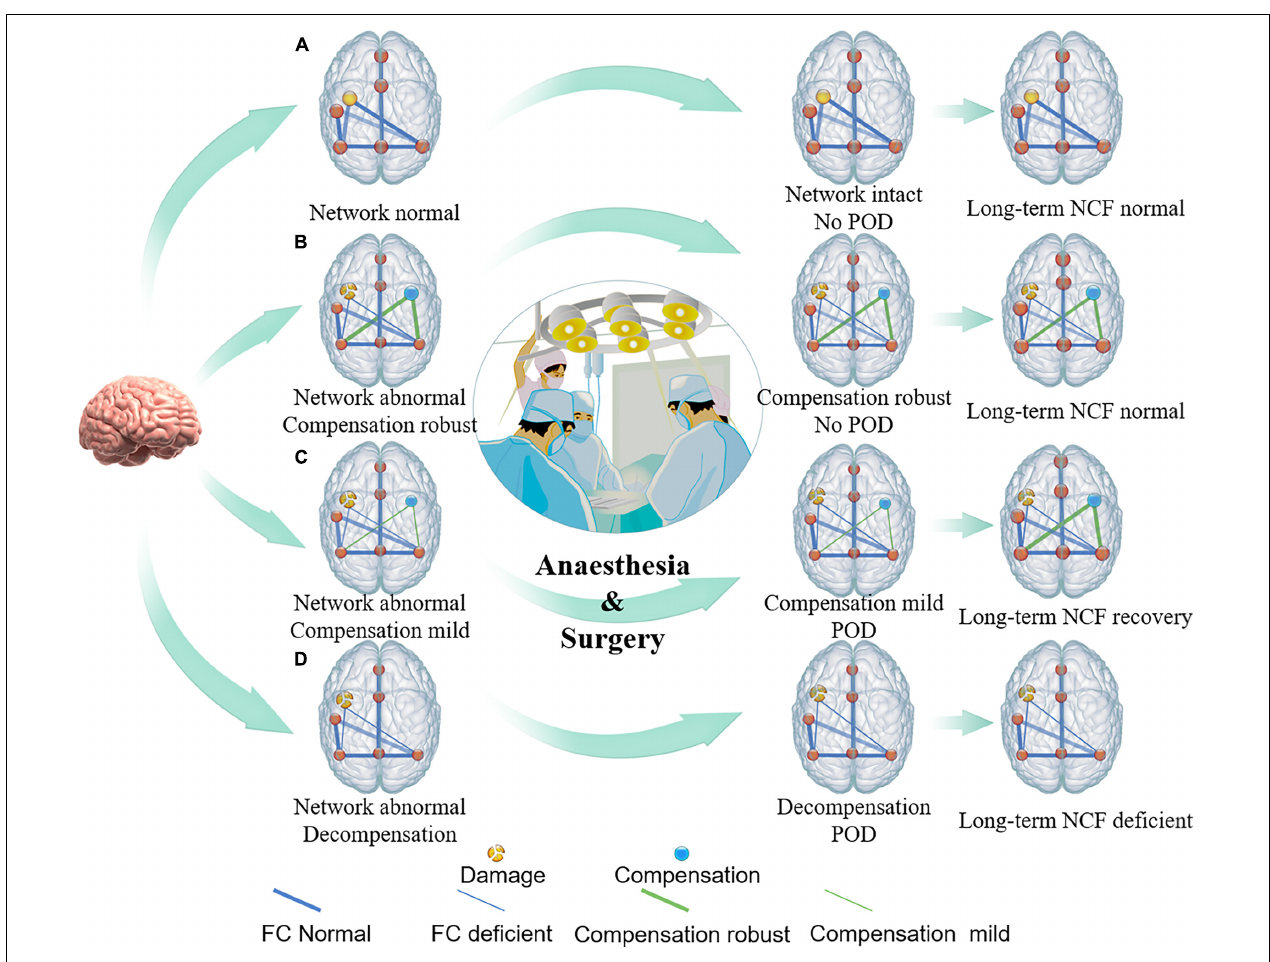
FIGURE 4 | Conceptual model of relationship between brain damage, brain compensation, and POD. The conceptual model illustrates that premorbid integrity of individual brain regions (yellow intact or broken dots on the left side of brain) and/or brain connectivity (thick or thin blue line), as well as robustness of brain compensation (yellow dots and green line on the right side of brain), may relate to the POD incidence under conditions of heightened stress from surgery. (A) Individuals with intact brain structure and function, such as healthy young people, can accommodate surgical stress, and, thus, do not suffer from POD. (B) Individuals with impaired brain structure and (or) function but robust compensation, such as some chronic brain-injured patients, including brain benign tumor and patients with high education level et al may also be less likely to suffer POD. (C) Individuals with impaired brain structure and (or) function but insufficient compensation, such as relative fast brain-injured patients including brain tumors with low malignancy are prone to have the symptoms of delirium after suffering from a surgical strike. As the stressor resolves, brain compensation may continue to occur, and, thus, long-term cognitive function will be restored or might be less affected. (D) When brain structure and (or) function were impaired but compensation, or decompensation, has not yet been established, such as highly malignant brain tumor, acute stroke, traumatic brain injury, Alzheimer’s disease, etc., individuals with greater vulnerability experience greater POD incidence, duration, and